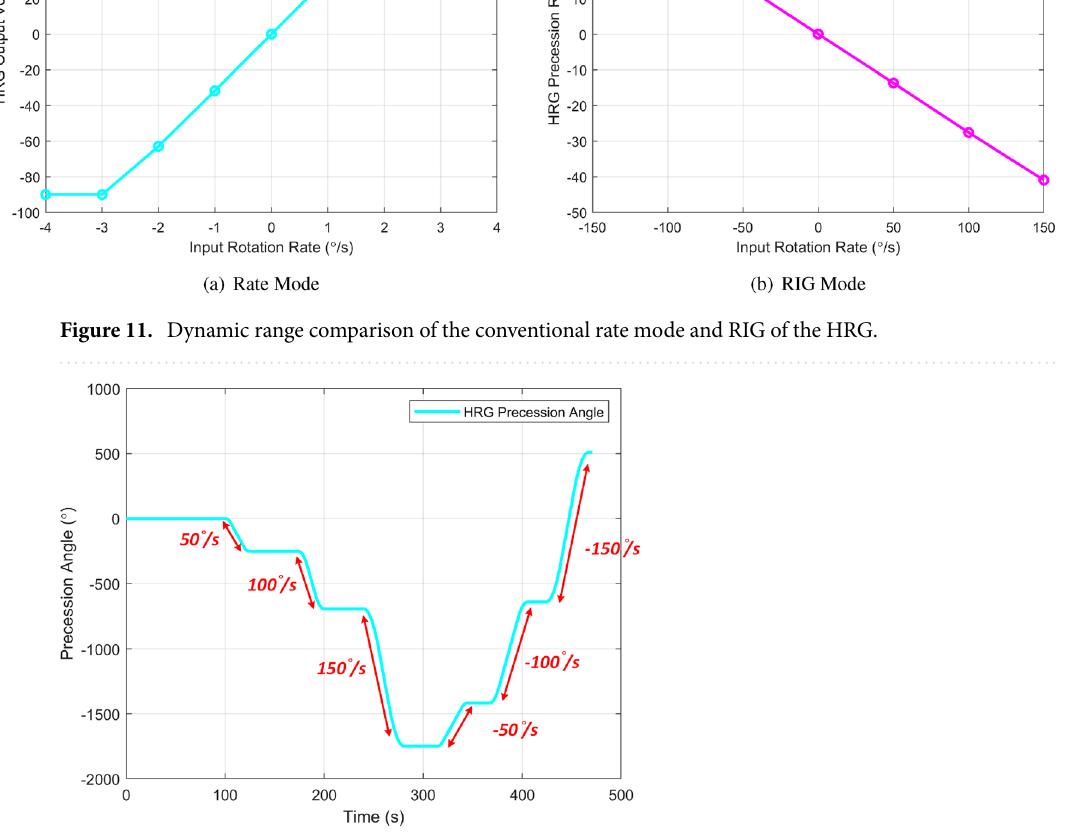
Figure 12. Step responses of the HRG RIG with different